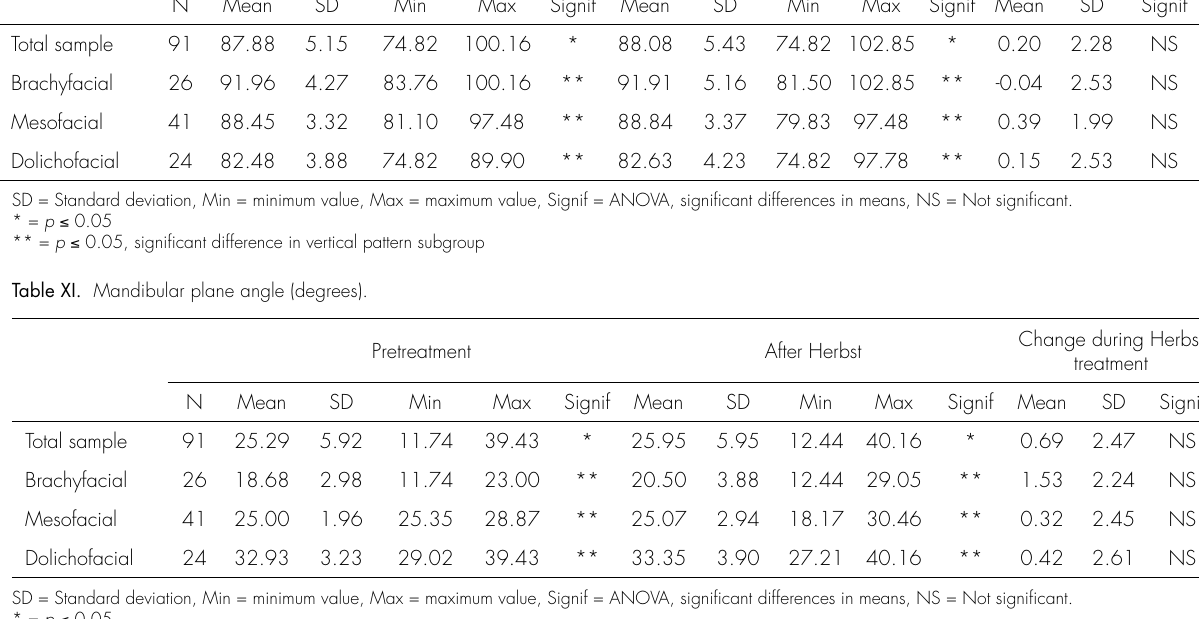
SD = Standard deviation, Min = minimum value, Max = maximum value, Signif = ANOVA, significant differences in means, NS = Not significant. * = p ≤ 0.05 ** = p ≤ 0.05, significant difference in vertical pattern subgroup Table XII. Significant correlation of cephalometric variables with pretreatment variables.